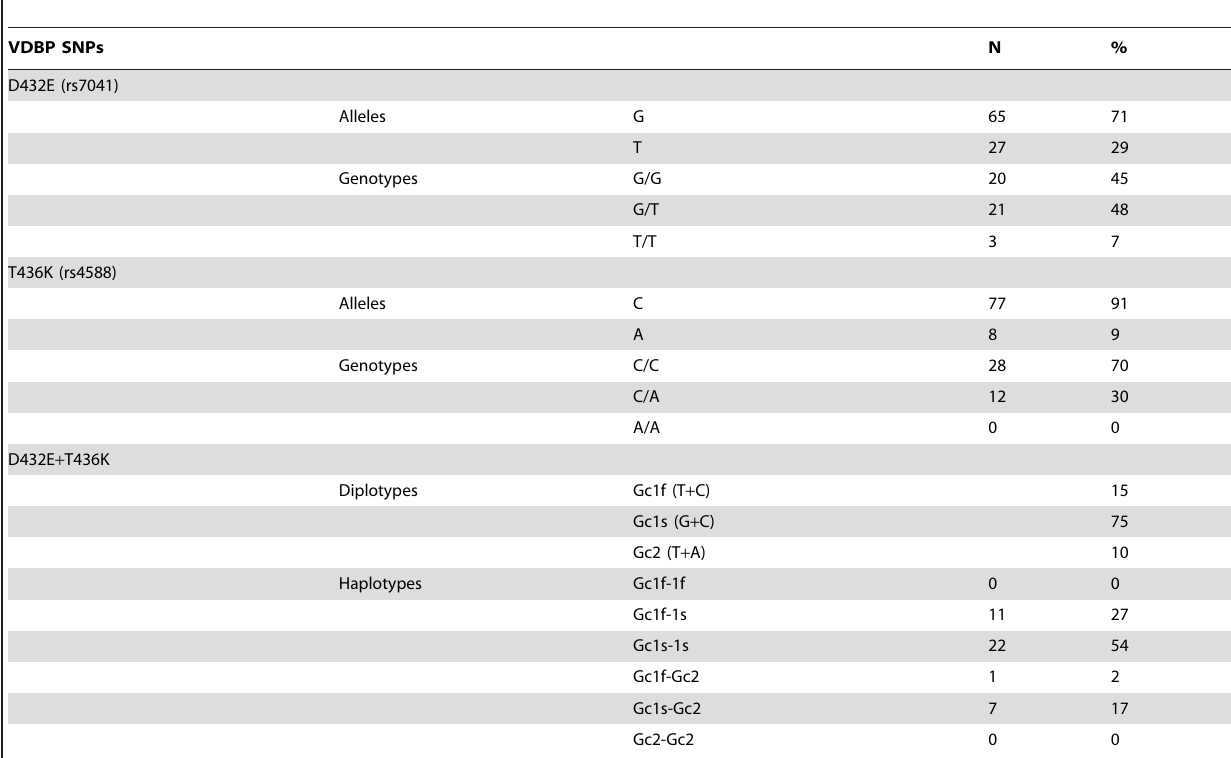
Table 2. Alleles and genotype frequencies for the vitamin D binding protein (D432E and T436K).